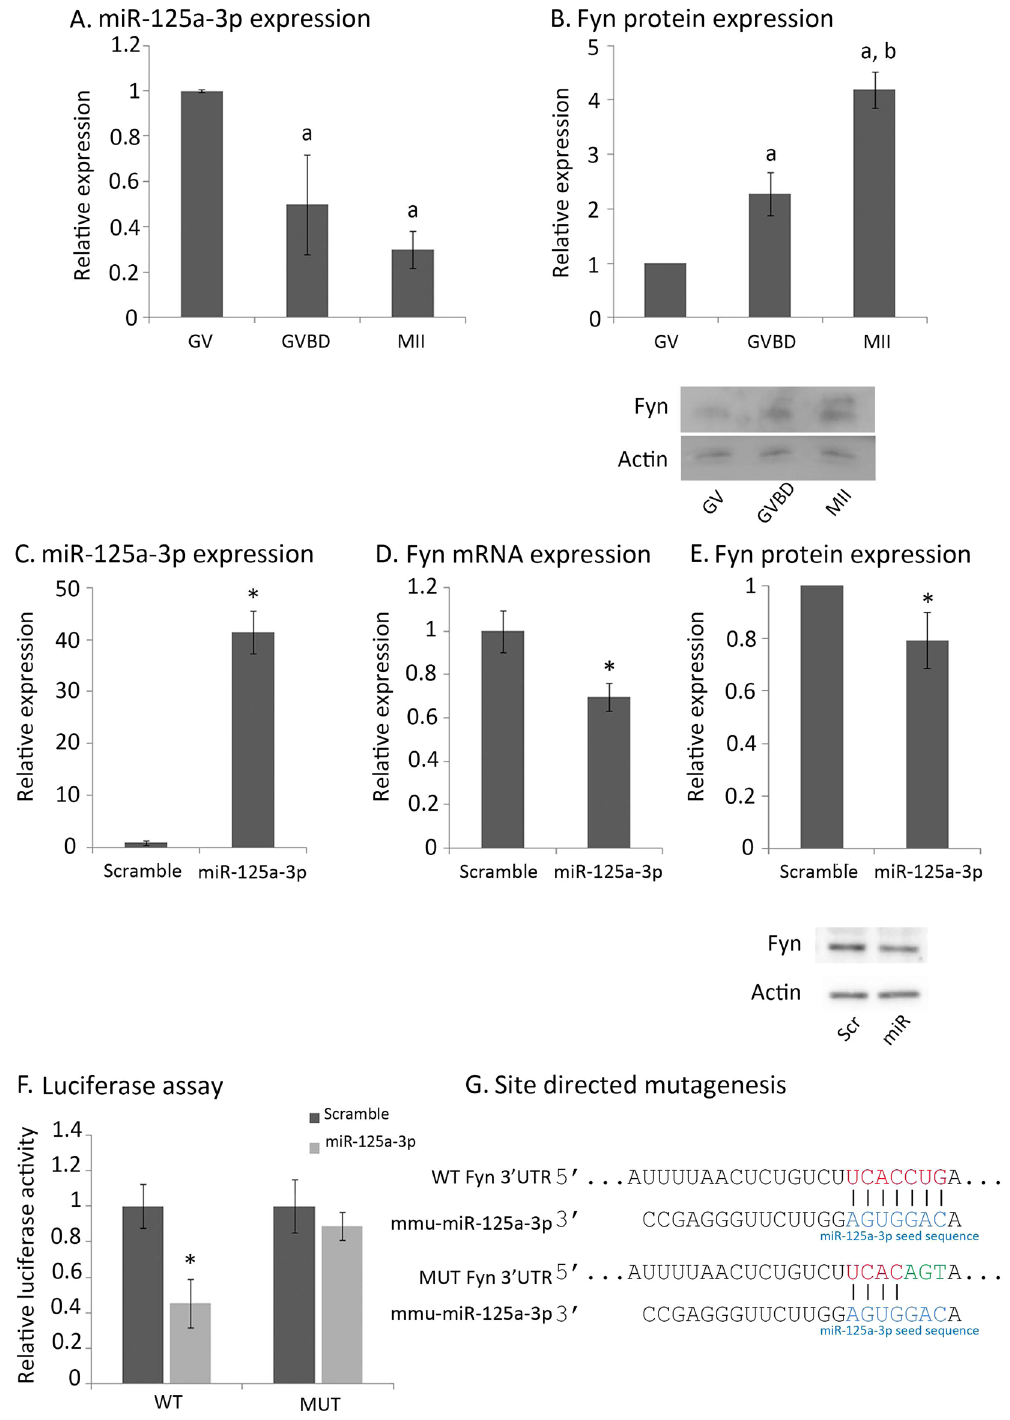
Figure 1. miR-125a-3p down-regulates Fyn expression in oocytes by a direct binding to Fyn 3 ′ UTR. ( A , B ) Inverse correlation between miR-125a-3p and Fyn protein during maturation: RNA (30 oocytes at each experimental group) and protein (75 oocytes at each experimental group) were extracted from GV, GVBD and in-vivo matured MII oocytes. Whole cell lysates were subjected to ( A ) qPCR analysis for the detection of miR- 125a-3p and U6-snRNA, which served as an internal control; or to ( B ) western blot analysis for detection of Fyn protein expression, with actin serving as an internal control (upper – graph; lower – a representative blot). Results were normalized to the value of GV oocytes. Data were analyzed by one-way ANOVA followed by Tukey post hoc test. Bars are Mean ± SD of four ( A ) or three ( B ) independent experiments. a,b p < 0.05; a versus GV oocytes; b versus MII oocytes. ( C – E ) GV oocytes were microinjected with miR-125a-3p mimic (miR-125a-3p) or scramble-miR (Scramble) as control, and incubated for four hours at 37 °C in the presence of 1 µ M milrinone. RNA (30 oocytes at each experimental group) and proteins (75 oocytes at each experimental group)